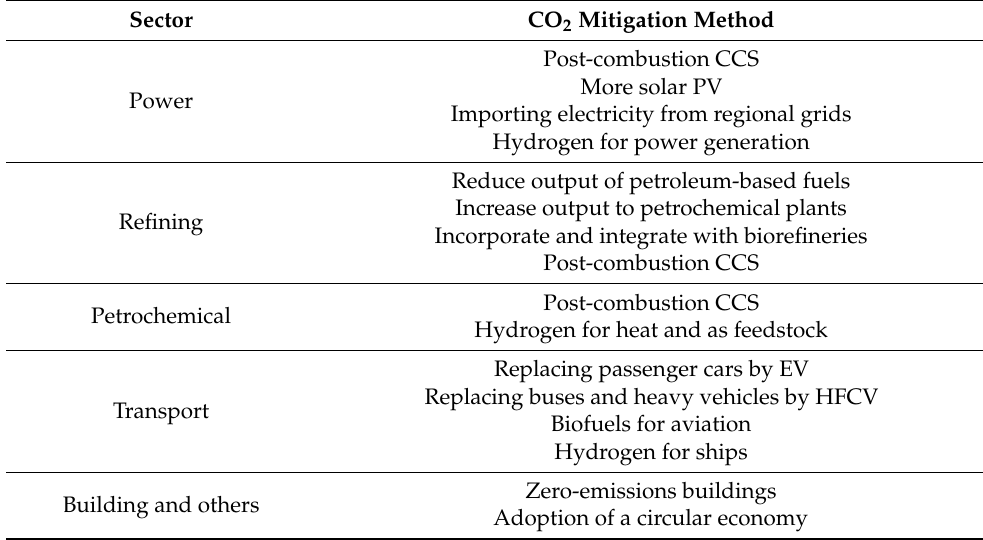
Table 2. CO 2 mitigation method by